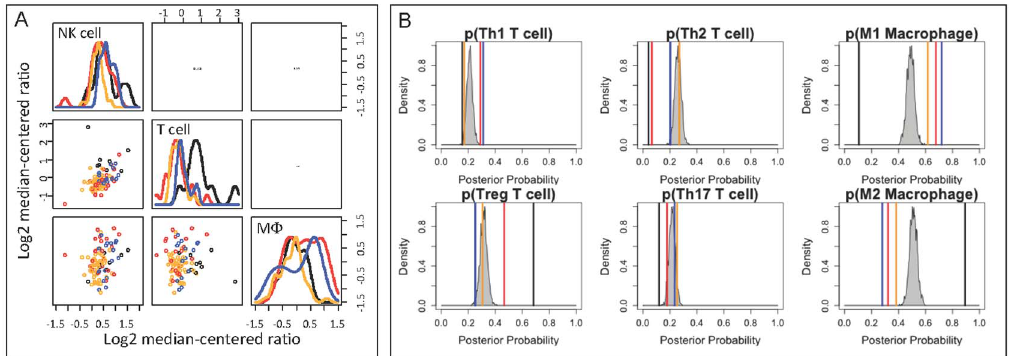
Figure 7. Hierarchical clusters of GEMM gene expression exhibit different immune cell signatures. (A) Relative immune cell infiltrate was estimated based upon the average expression of genes associated with NK cells (KLRD1, KLRC2, KLRC3), T cells (CD247, CD3G, CD3D, CD3E), and macrophages (CD14, CPM, MRC1, ITGAM) in the breast cancer GEMM data set [46]. (B) Using model-based inference, the mean posterior probabilities associated with T helper cell and macrophage polarization in each GEMM group were estimated based upon mutually exclusive gene expression patterns that are associated with each cell polarization subset, as listed in Table 1. The immune polarization signature was compared to a signature assembled from a bootstrapped ensemble of random sets of gene expression (i.e., a null hypothesis), as summarized by the gray shaded density distribution. In both panels, results are colored by group indicated at the top of the GEMM heatmap shown in Figure 6 (Normals - black, Group 1 - red, Group 2 - blue, and Group 3 - orange). In panel A, bivariate scatter plots are shown below the diagonal, marginalized histograms stratified by the three groups are shown on the diagonal, and correlation coefficients are shown above the diagonal.